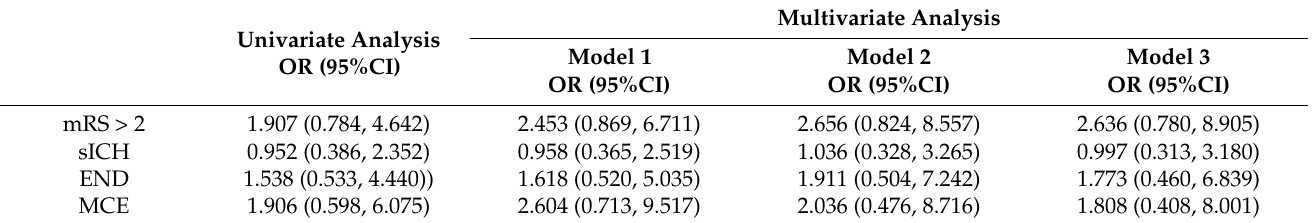
CSVD, cerebral small vessel diseases; mRS, the modified Rankin scale; sICH, symptomatic intracranial hemorrhage; END, early neurological deterioration; MCE, malignant cerebral edema; OR, odd ratio. Model 1 was adjusted for demographics and vascular risk factors, including age, sex, history of hypertension. Model 2 was adjusted for variables in model 1, plus HDL and Hcy. Model 3 was adjusted for variables in models 1 and 2 and TICI scores of 2b/3. Considering the whole population, we then evaluated the association between indi- vidual CSVD imaging markers, including WMH and EPVS, and outcomes. In univariate regression analyses, the patients with EPVS-CS were significantly associated with an in- creased risk of END (OR: 7.89, 95% CI: 1.0, 62.53). However, PWMH, DWMH, or EPVS-BG were not associated with 90-day mRS, END, sICH, or MCE. All variables with p < 0.1 in the univariate analysis were entered into a multivariate logistic regression with a backward procedure. In the multivariable analysis, after adjusting for covariates, the poor functional outcomes (mRS > 2) were associated with DWMHs (OR: 3.624, CI: 1.12, 11.69), and END continued to be more likely in patients with EPVS-CS (adjusted OR: 14.78, 95% CI: 1.36, 160.64). In addition, patients with PWMH, DWMH, or EPVS-BG were also associated with END (Table